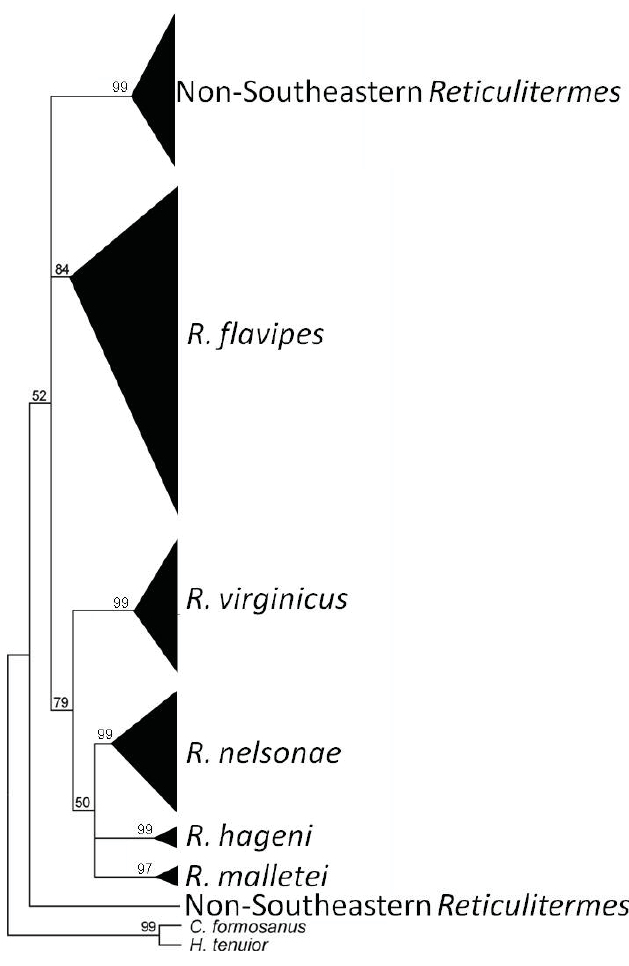
Figure 7. Maximum parsimony (MP) estimate of the Reticulitermes phylogeny based on mitochondrial ribosomal gene COI (767 bp) data. Collapsed tree topology illustrating the branch support and clades formed by Reticulitermes